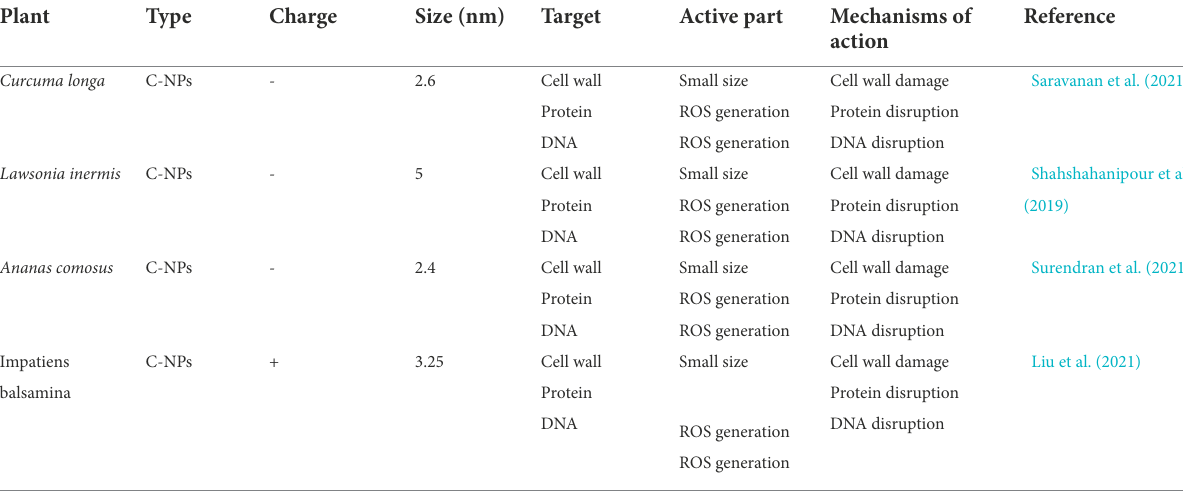
TABLE 4 Multiple antimicrobial action of plant-derived nanoparticles. Plant